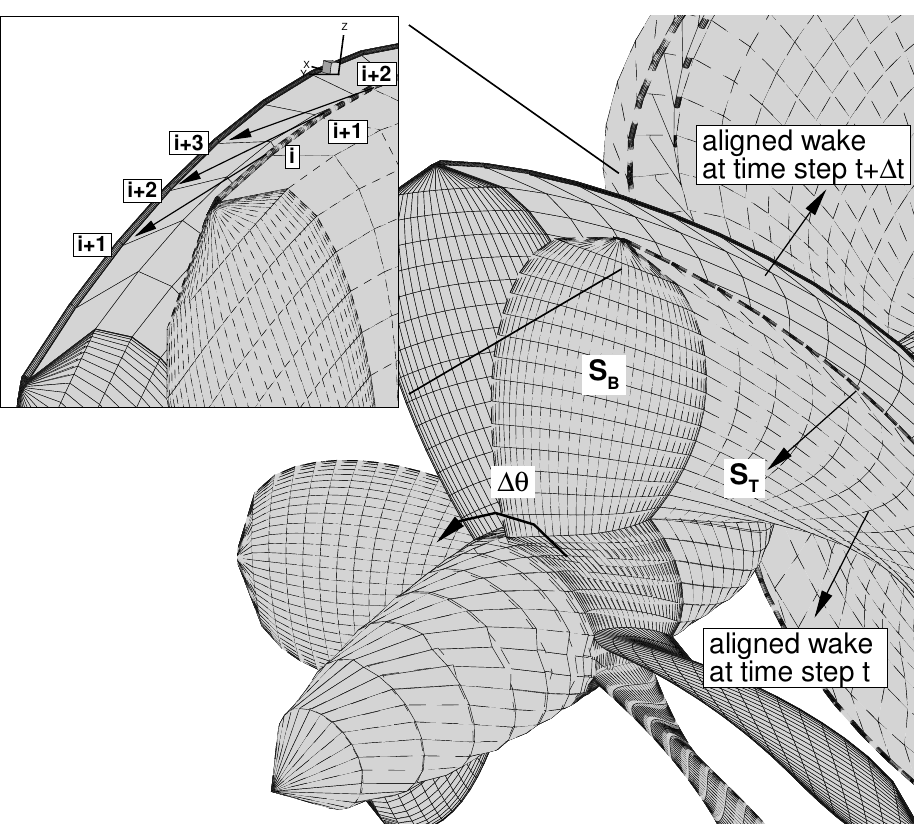
Figure 3. Schematics showing the wake alignment process from the time step t (dashed line mesh) to t + ∆ t (solid line mesh). Wake panels convect downstream with